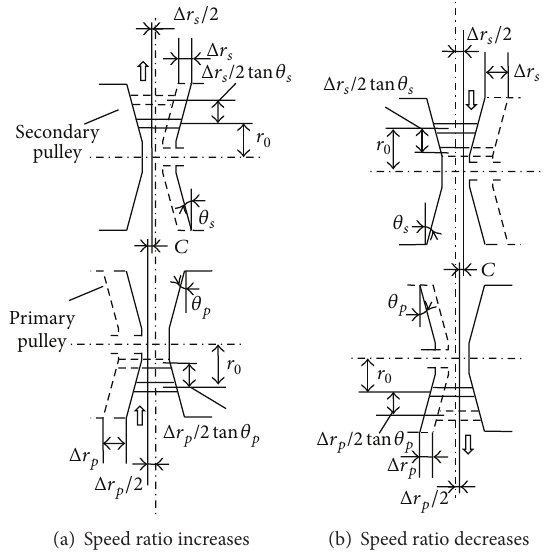
Figure 5: Axial misalignment of belt when